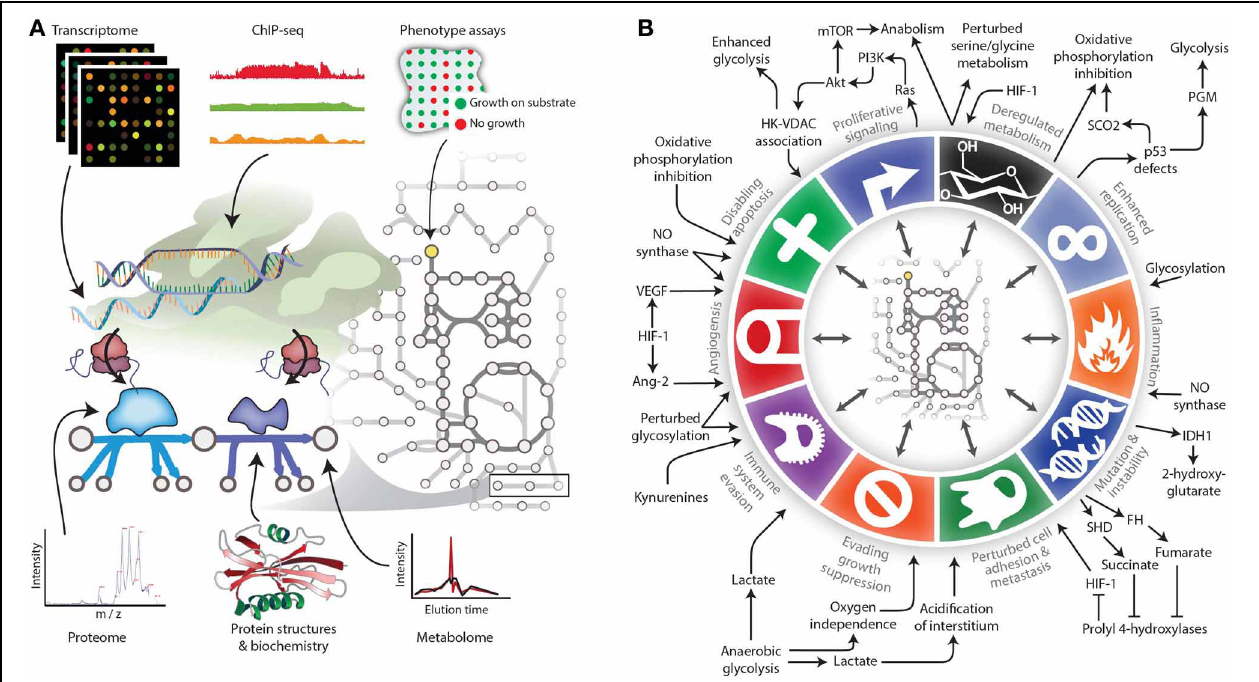
properties of the network such as growth rate under certain experimental conditions. (B) The various Hallmarks of Cancer either affect metabolism or are modulated by metabolic changes. Therefore, modeling techniques are needed to account for these interactions between metabolism and other cell processes. Panel B adapted from (Hanahan and Weinberg, 2011) and (Kroemer and Pouyssegur, 2008) with